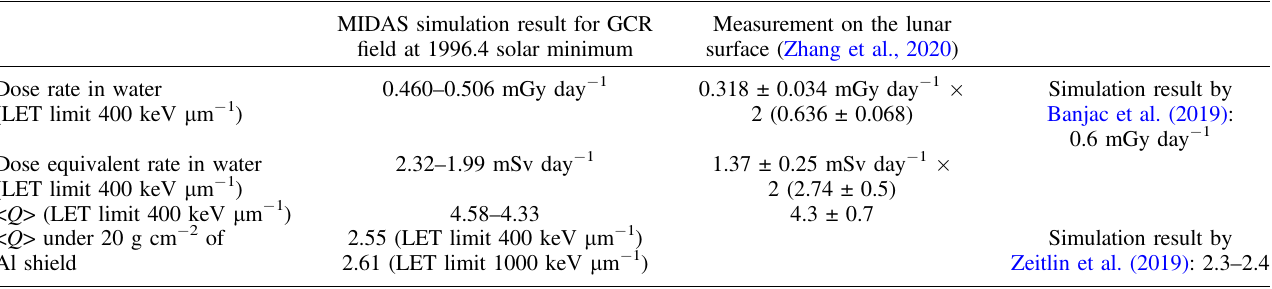
Table 1. Dose rates and quality factors from the MIDAS simulated response in 1996.4 solar minimum calculated using correction coef fi cients resulting from solar minimum and solar maximum GCR fi elds. They are compared with the measurements on the lunar surface, which are multiplied by 2. The 3rd column reports simulation results obtained using the Badwar O ’ Neil model and completely different methodologies than the one